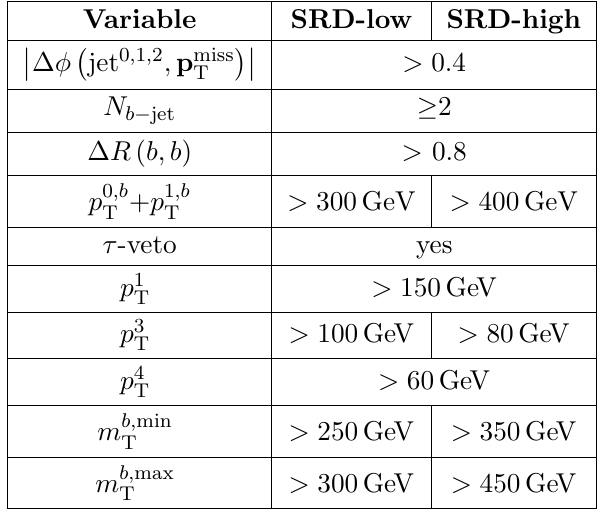
Table 3. Selection criteria for SRD, in addition to the common preselection requirements described in the